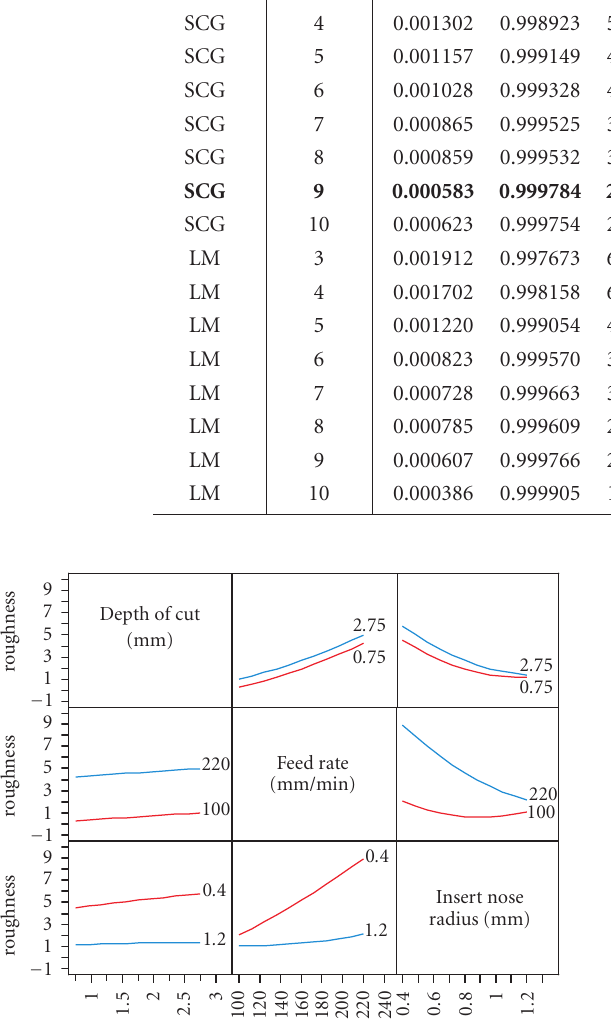
Figure 12: The interaction e ff ect plots of depth of radius, feed rate, and insert nose radius on the surface roughness in second-order model.